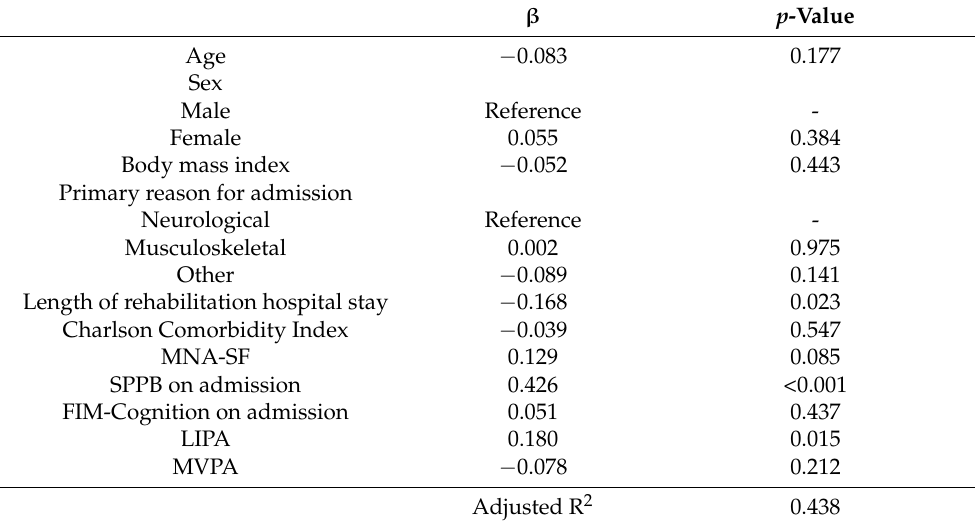
Table 2. Multivariate linear regression analysis for SPPB score at discharge.